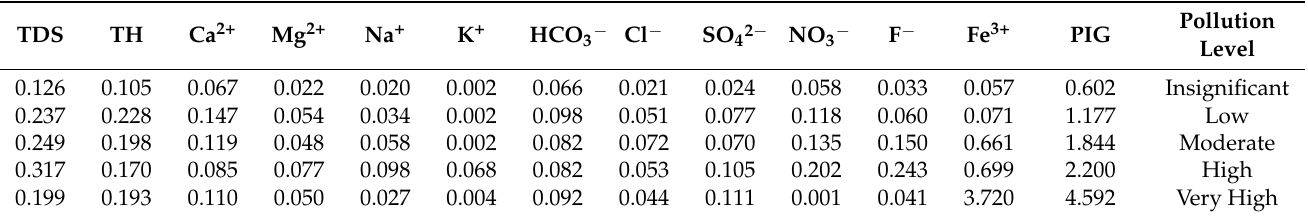
Figure 10. Distribution maps of PIG values, CRITIC-PIG values and Entropy-PIG values in the study area: ( a ) PIG values; ( b ) CRITIC-PIG values; ( c ) Entropy-PIG values . Table 7. Average values of the overall water quality of each chosen parameter in five pollution-level zones obtained using the PIG model.